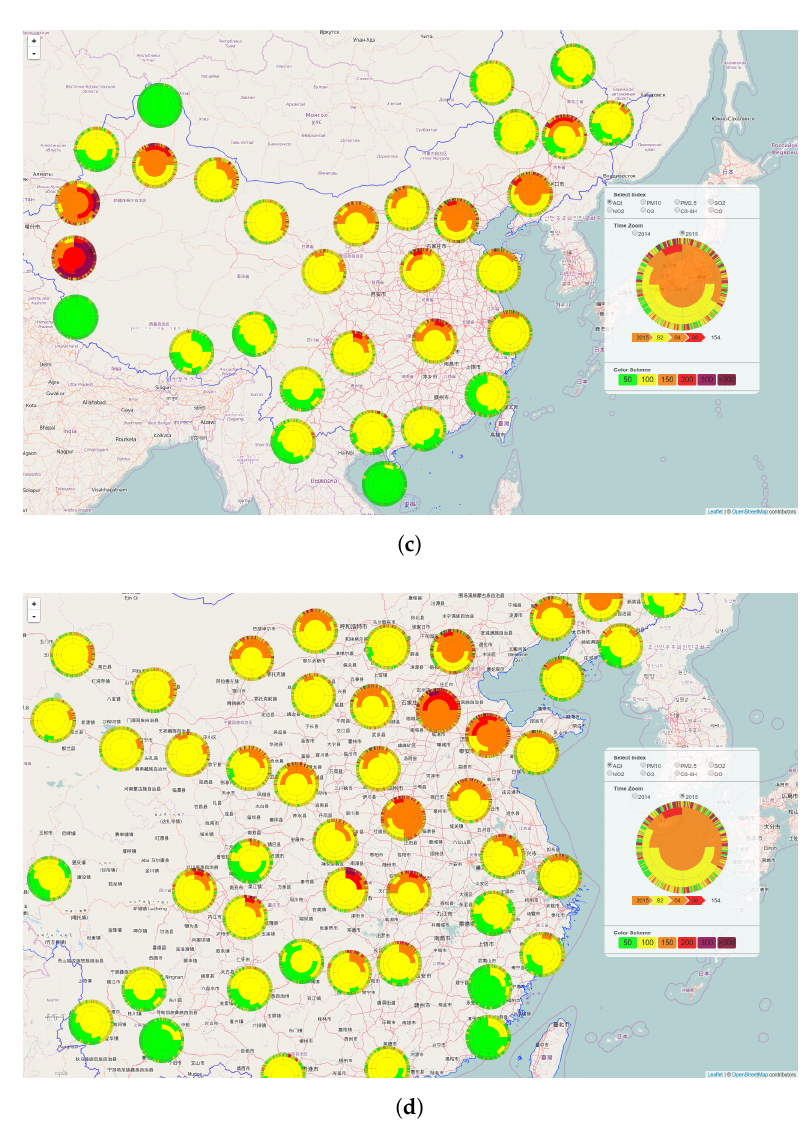
Figure 7. Spatial navigation. When zooming the map, the symbols are selected dynamically at each zoom level with the function provided by symadaptive.js. ( a )–( d ) illustrate map symbols at Zoom Levels 3–6 on the OpenStreetMap tiled map background. ( a ) Map Zoom Level 3; ( b ) Map Zoom Level 4; ( c ) Map Zoom Level 5; and ( d ) Map Zoom Level